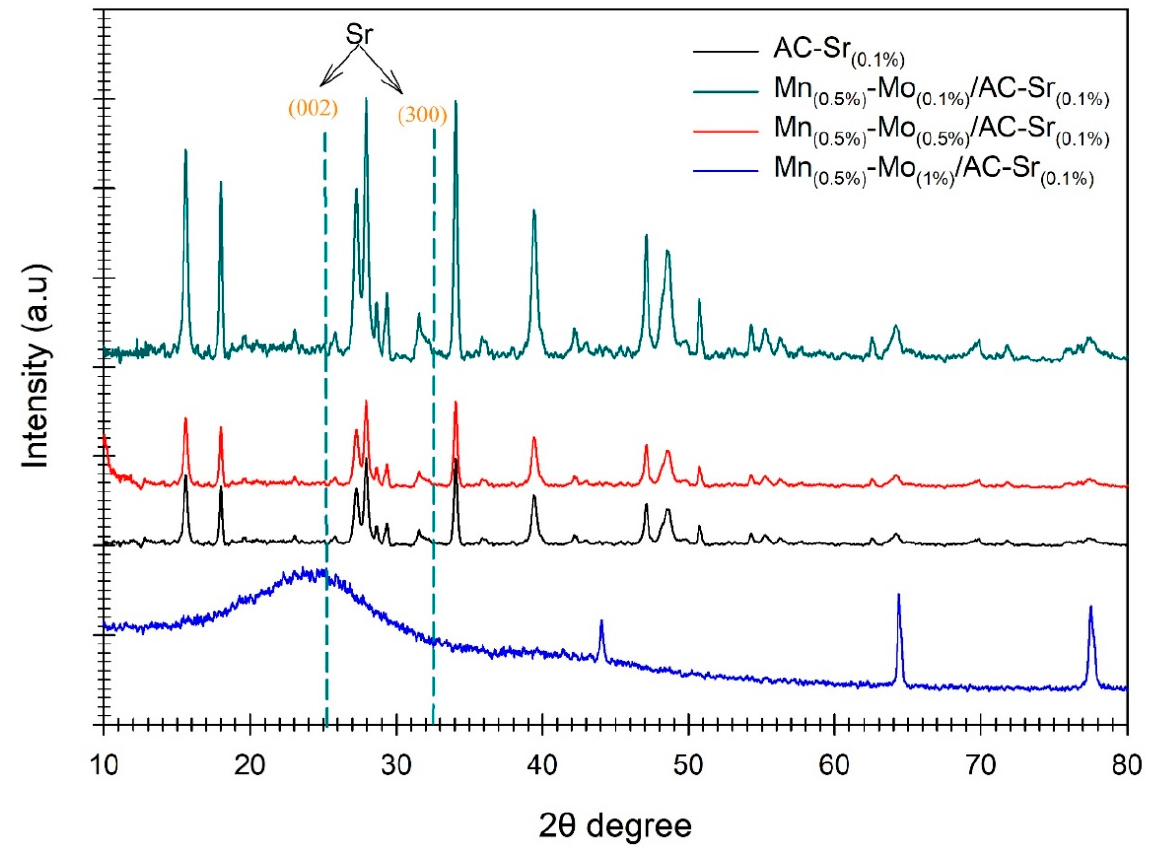
Figure 2. Structural properties of supports and catalysts . a XRD patterns of AC and Mn (0.5%) -Mo (0.5%) /AC, Mo (0.5%) /AC, Mn (0.5%) -Mo (0.1%) /AC and Mn (0.5%) -Mo (1%) /AC.